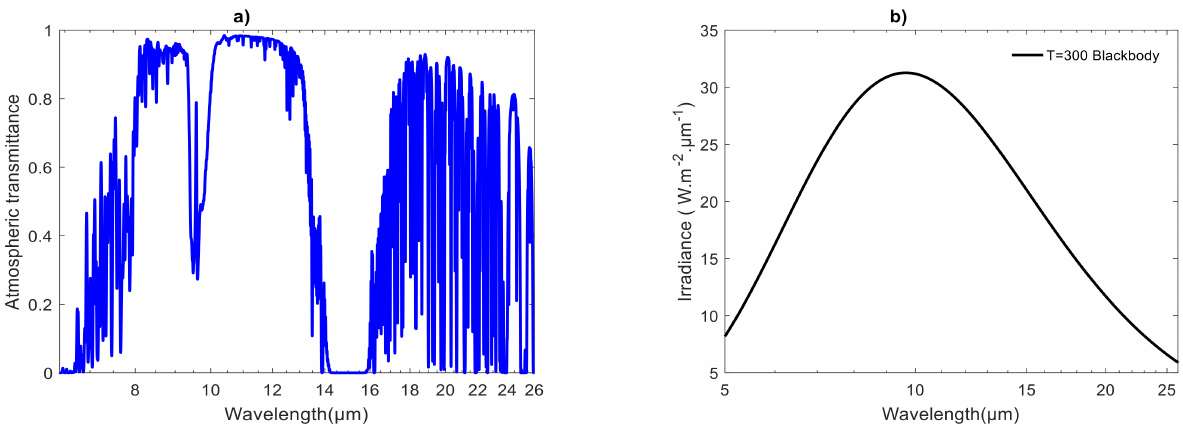
Figure 9. ( a ) The computed atmospheric transmittance spectrum, computed using Modtran/PcModWin model (shaded blue) and ( b ) the computed spectral irradiance of a black body at 300 K (shaded